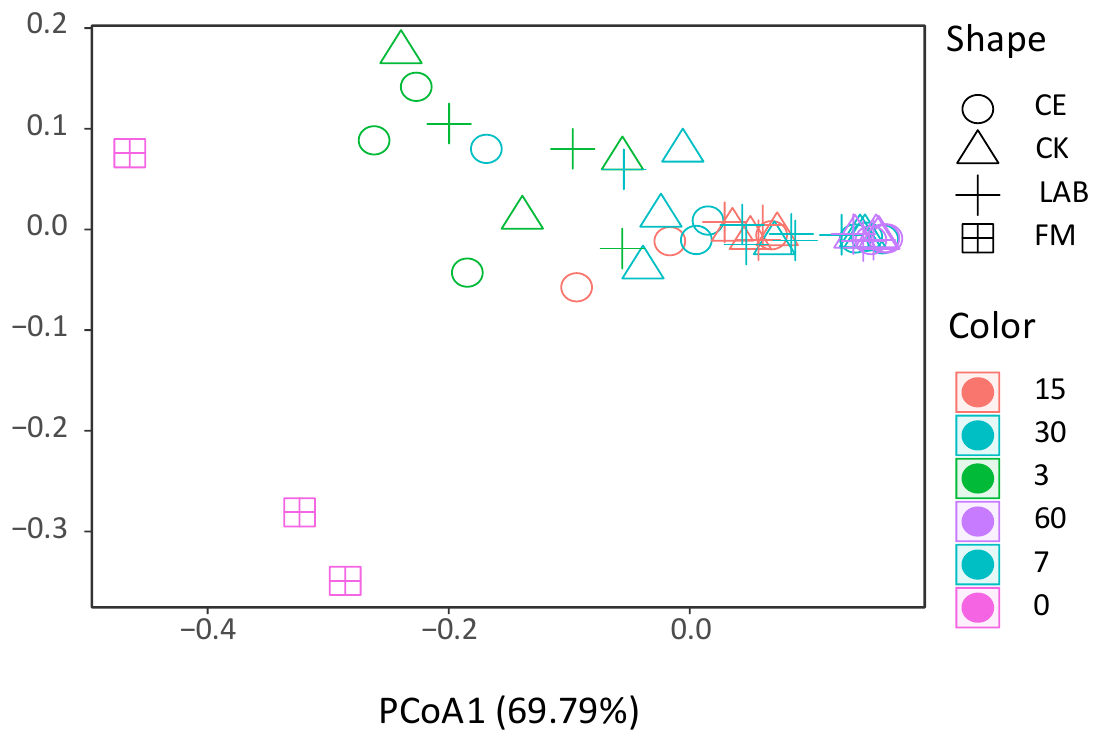
position in the LAB group during the whole silage process. The abundance of Lactiplantibacil‑ lus was higher in the CE (90.19%) and LAB groups (88.40%) at 60 days of ensiling compared to the control group (78.05%). Figure 2B shows the one‑way ANOVA of phylum level between FM and silage groups after 60 days of Caragana korshinskii ensiling, and there was a signifi‑ OTUs, operational taxonomic units; CK, no additive control; CE, cellulase; LAB, lactic acid bacteria. cant difference between FM and silage in the phylum Firmicutes and Proteobacteria ( p < 0.05). Different capital letters indicate significant differences among different treatments under the same One‑way ANOVA of genus level showed that Lactiplantibacillus , Pediococcus , Enterobacter, and ensiling days ( p < 0.05); different lowercase letters indicate significant differences among different Klebsiella had significant ( p < 0.05) differences between FM and silages (Figure 2D). The ad‑ ensiling days under the same treatment ( p < 0.05); no or same letter indicate not significant ( p > ditive treatment groups effectively reduced the abundance of Pediococcus and increased the 0.05). SEM, standard error of the mean; T, treatments; D, ensiling days; T × D, interaction between abundance of Lactiplantibacillus compared to the control group. treatments and ensiling days.